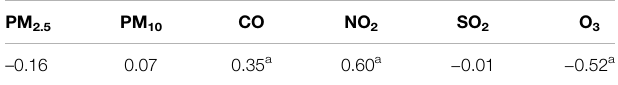
TABLE 2 | Correlation analysis between Google mobility data and air pollutant concentrations at different monitoring stations in the restrictive measures period